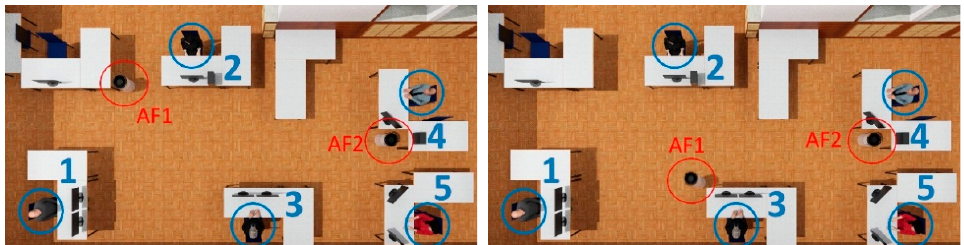
Figure 14. Geometry of baseline ( left ) and changed filter position ( right ). AF1: air filter 1, AF2: air filter 2. The numbering of the people locations in blue remain as previously.